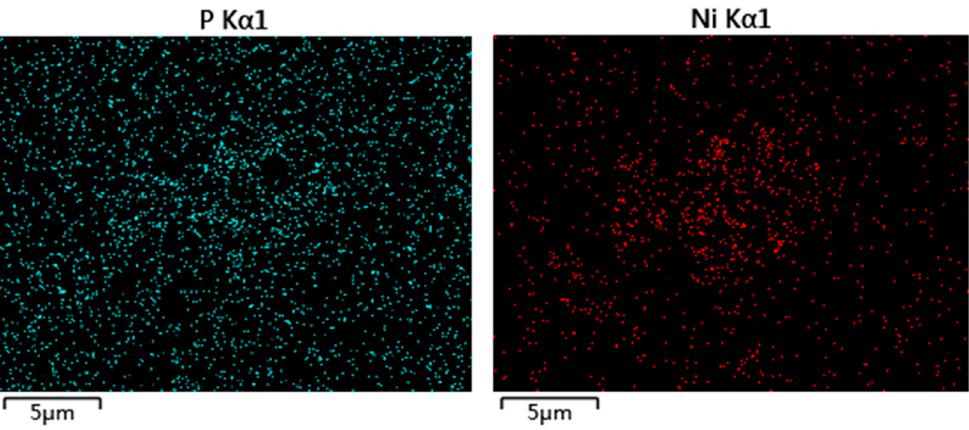
Figure 6. SEM-mappings of NiP/H β calcined at 200 °C.